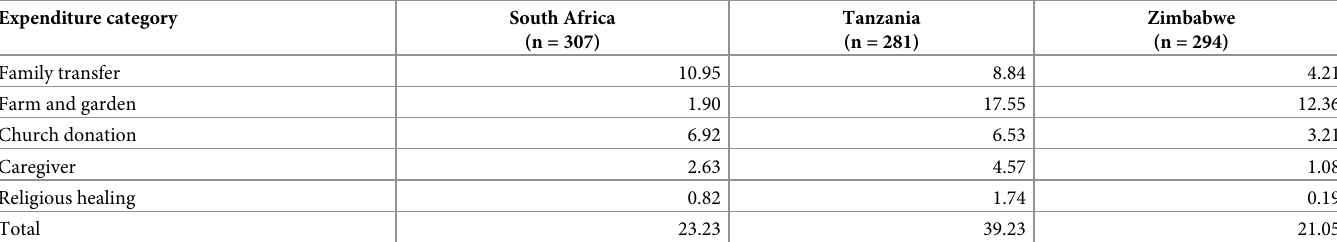
Table 3. Mean monthly household per capita expenditure on items included in the diaries only, 2014